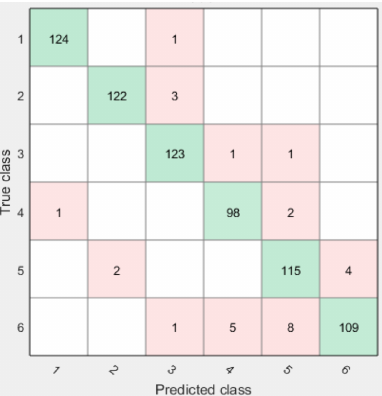
Figure 9. The results obtained from the Cubic SVM model implemented in C++, to operate in the ROS framework. Table 3. Accuracy of the implemented Cubic SVM learned model, when applied to new data samples. Class Number